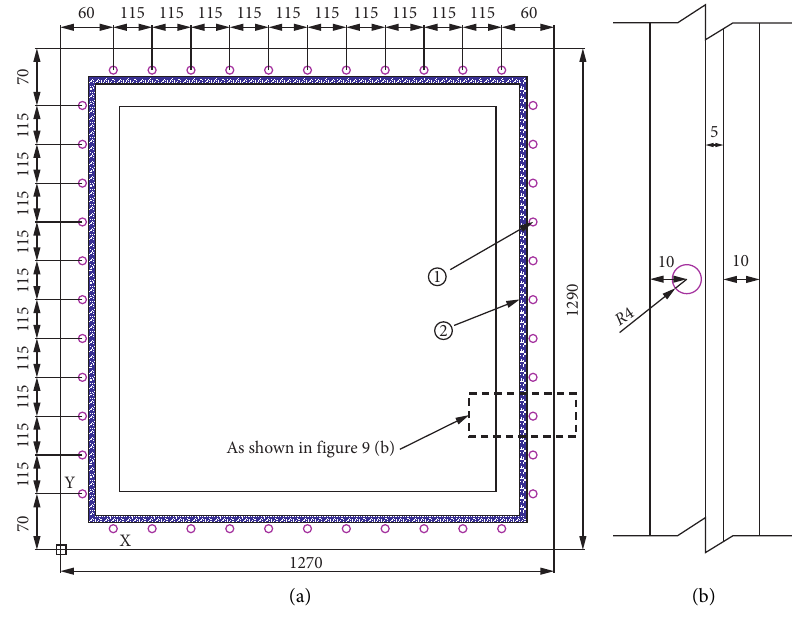
Figure 9: (a) Bolt hole layout. (b) Bolt hole layout details.